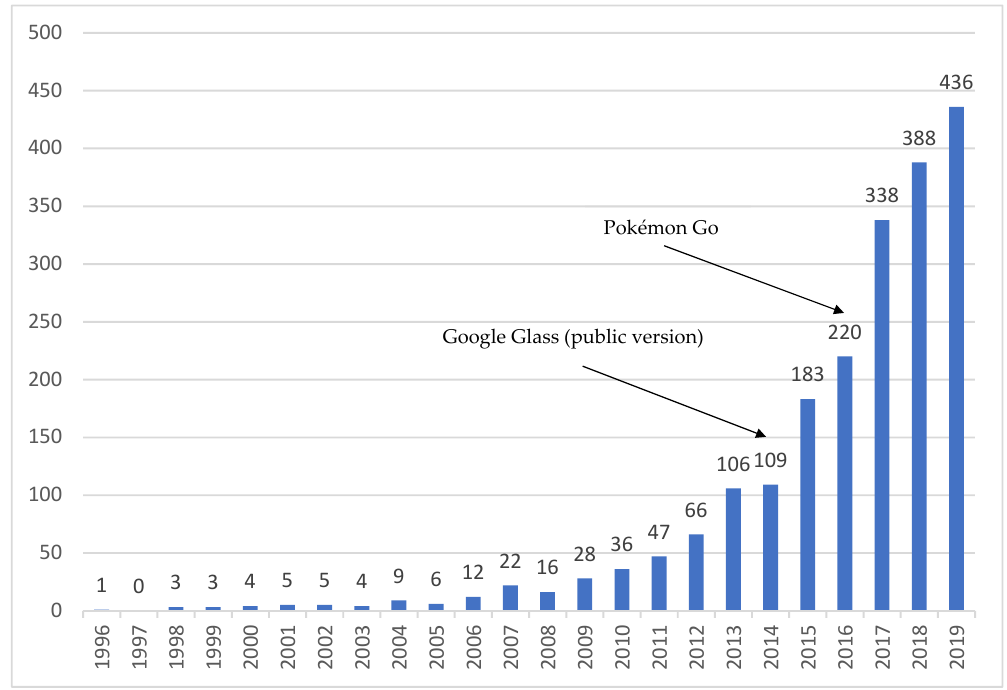
Figure 1. Number of studies of AR in education per year in the WoS.